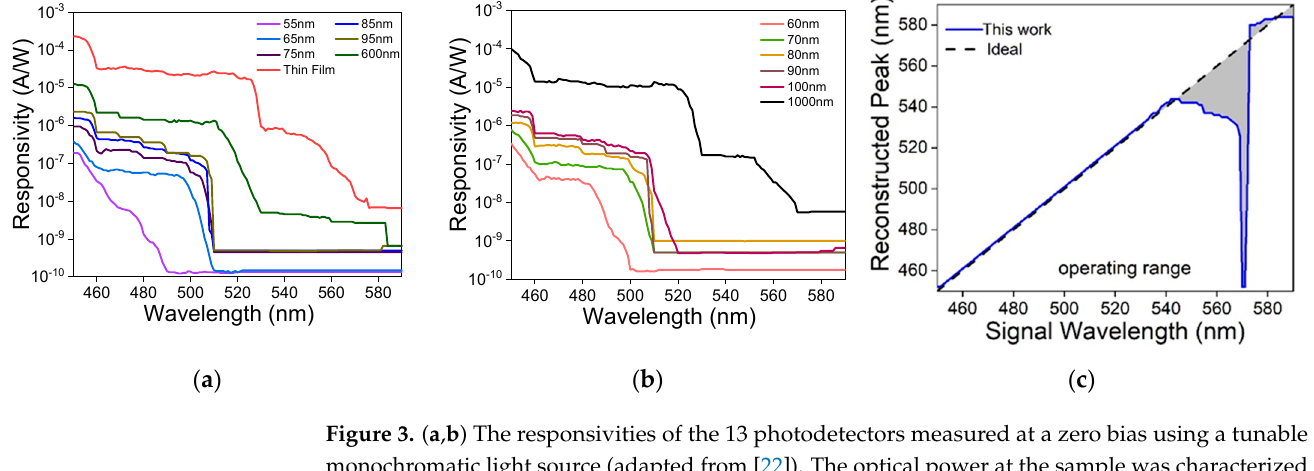
Figure 3. ( a , b ) The responsivities of the 13 photodetectors measured at a zero bias using a tunable monochromatic light source (adapted from [22]). The optical power at the sample was characterized separately using an integration sphere. The photocurrent was measured using a semiconductor parameter analyzer (Keithley 4200). The legend shows the nanopillar’s diameter in each photodetector. ( c ) Determination of the spectrometer’s operating range using an NNLS algorithm with a series of delta-function spectra between 450 nm and 590 nm. The shaded area from 541 to 590 nm indicates the wavelength range in which the reconstruction has a large error. The result implies an operating range from 450 nm through 540 nm.